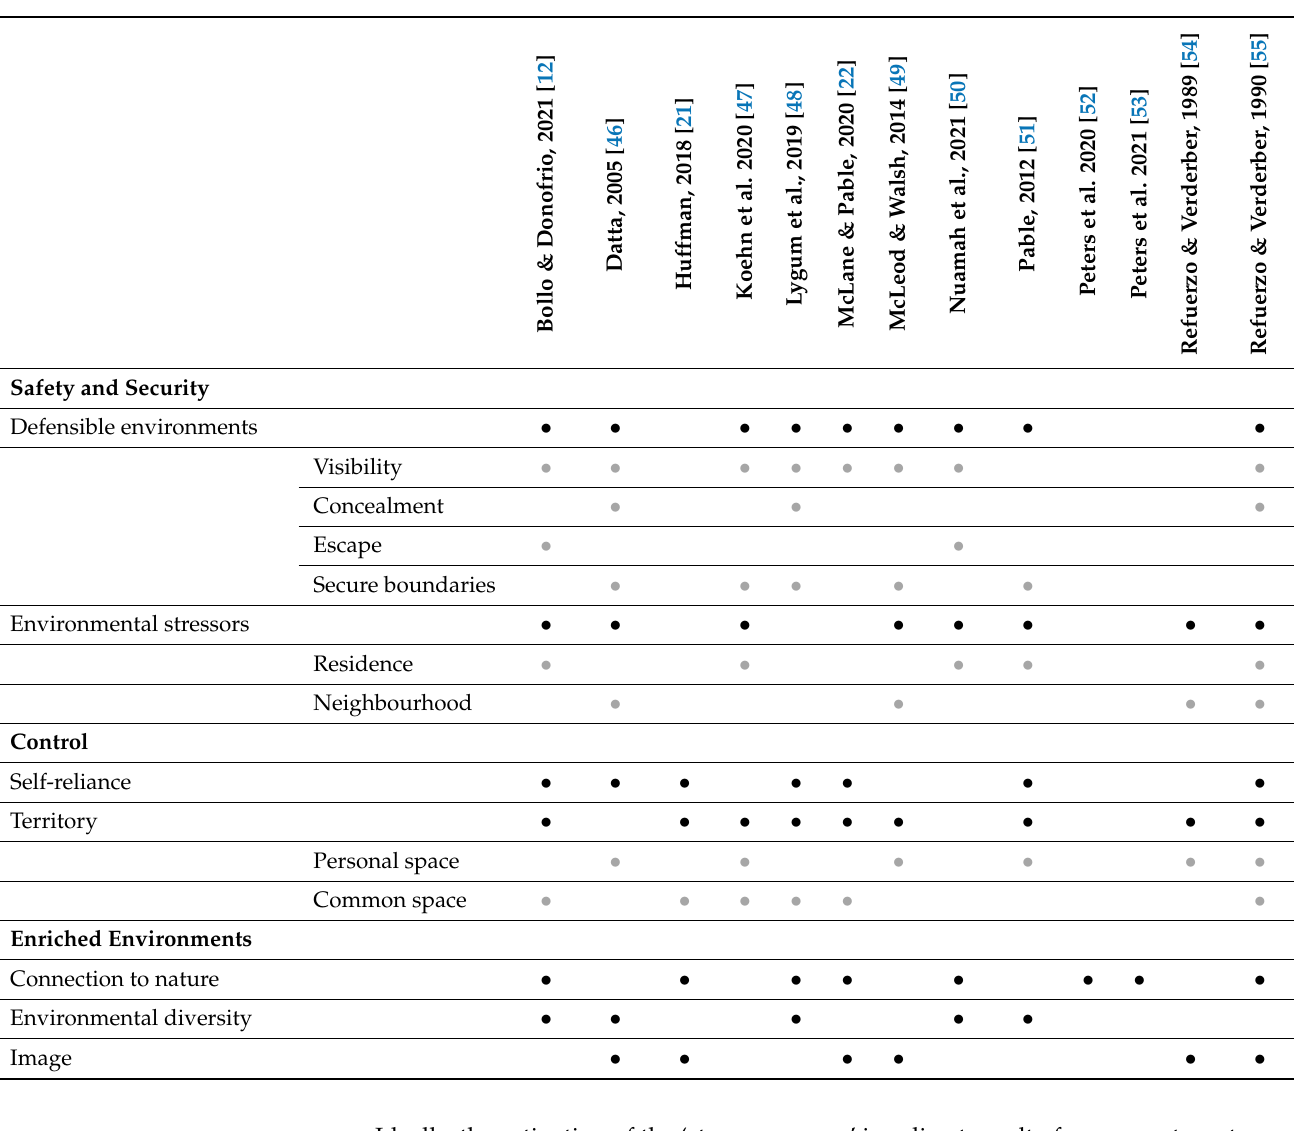
Table 3. Summary of Domains and Themes in Relation to Reviewed